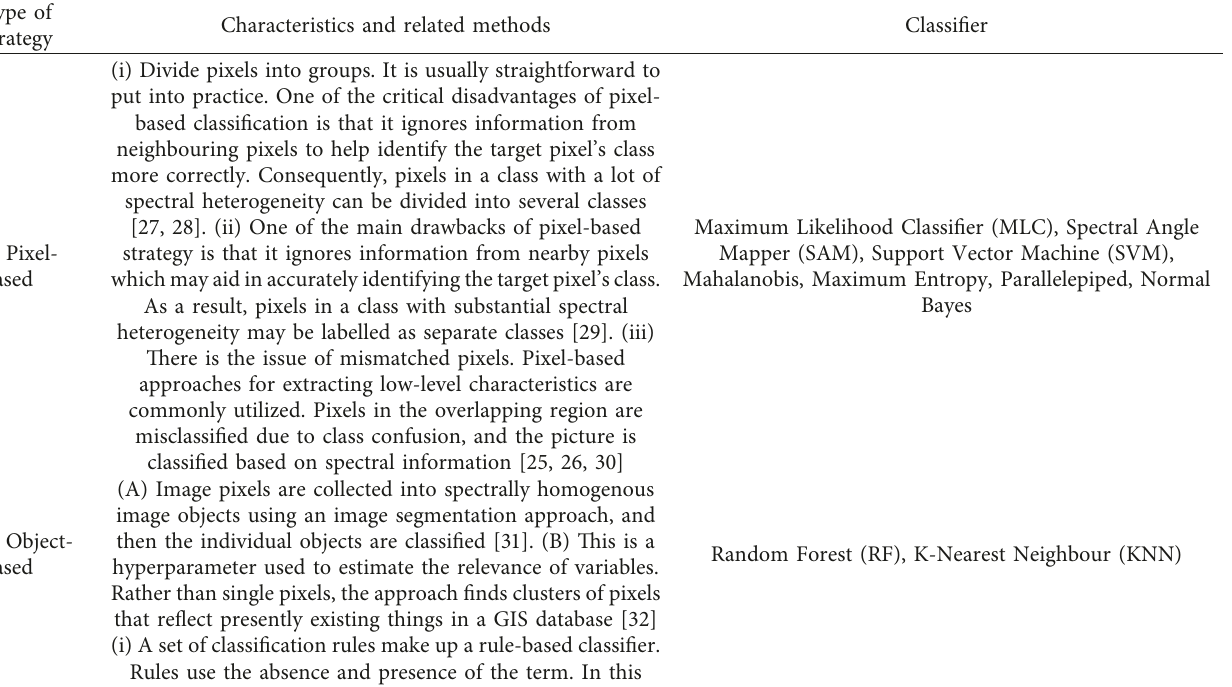
Table 1: Strategies of AI